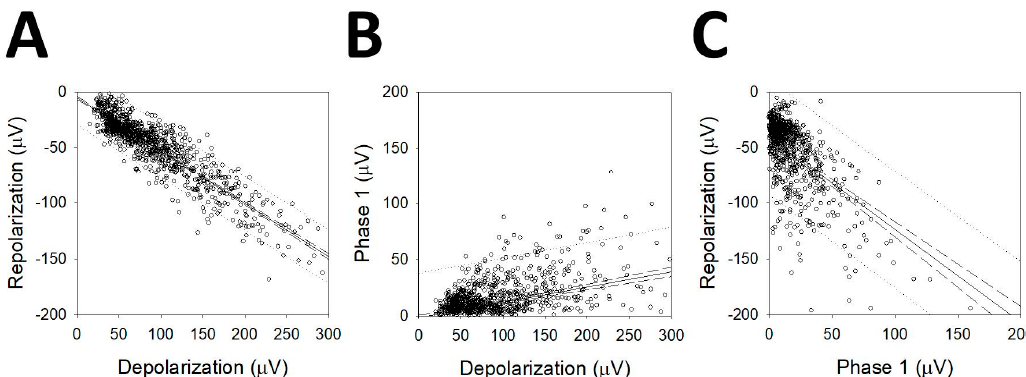
Figure 6. Linear regression for the maximum amplitude of the different phases of mAPs. ( A ) Depolarization vs. repolarization; ( B ) depolarization vs. phase 1 and ( C ) phase 1 vs. repolarization. Solid lines represent linear regressions; dashed lines represent 95% confidence band and dotted lines 95% prediction band.